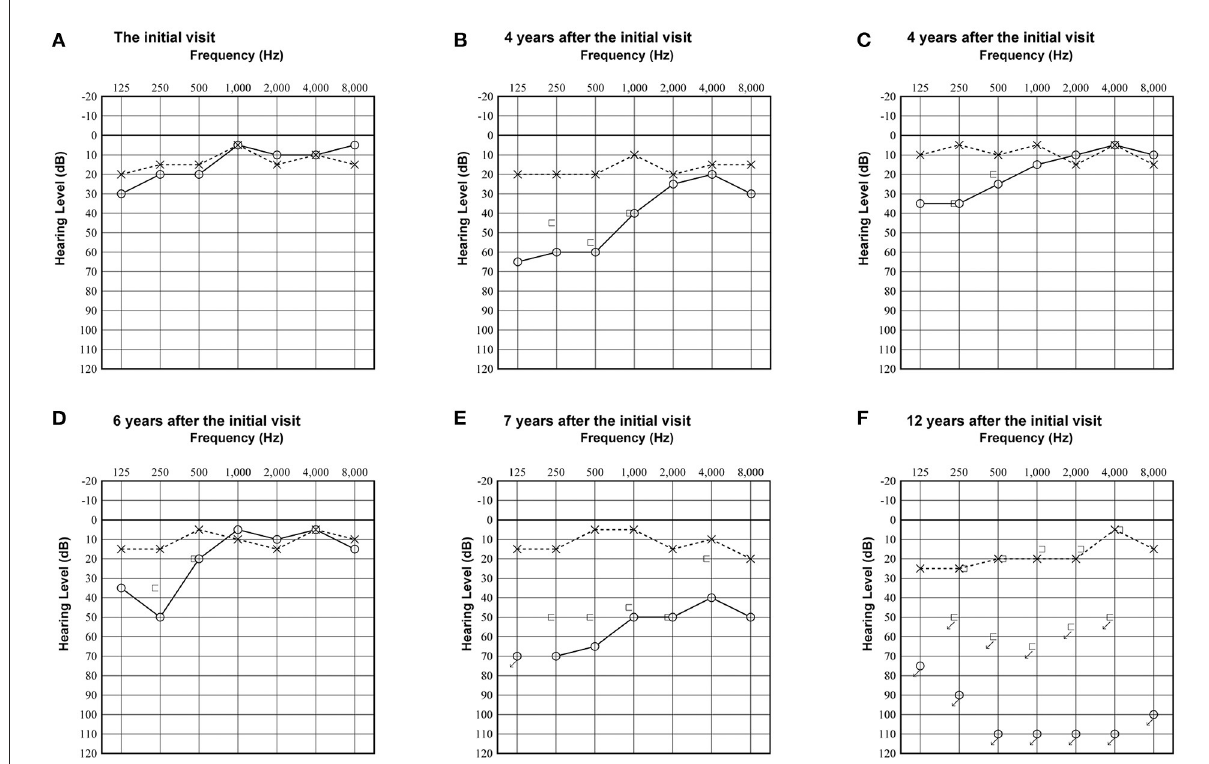
FIGURE1 Pure-tone audiogram at the initial visit showed almost normal hearing threshold on both sides (A) . Audiogram 4 years after the initial visit revealed moderate sensorineural hearing loss in the right ear at low and middle frequencies (B) . Audiogram after treatment with corticosteroid with partial hearing improvement (C) . Audiogram 6 years after the initial visit showed mild hearing loss in the right ear only at low frequencies (D) . Audiogram 7 years after the initial visit revealed severe hearing loss in the right ear at all frequencies (E) . Audiogram 12 years after the initial visit showed profound sensorineural hearing loss in the right ear (F)